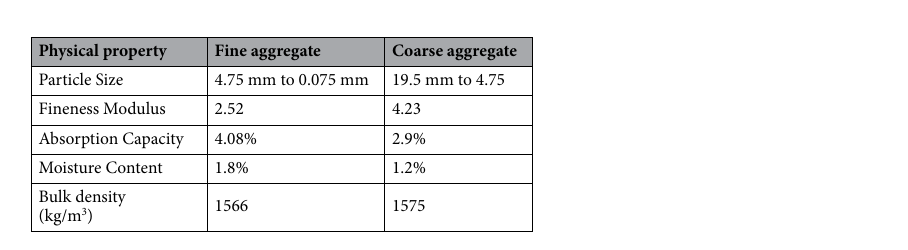
Table 3. Properties of aggregate.